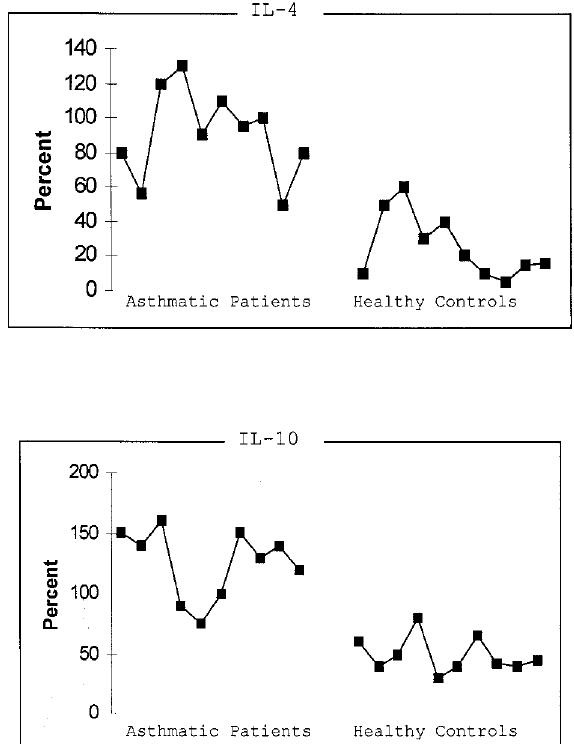
FIG. 3. Individual expression of mRNA for IL–4 and IL–10 in asthmatic patients and healthy controls in sputum mono- nuclear cells. The expression of mRNA is shown as percen- tages relative to the signals of b